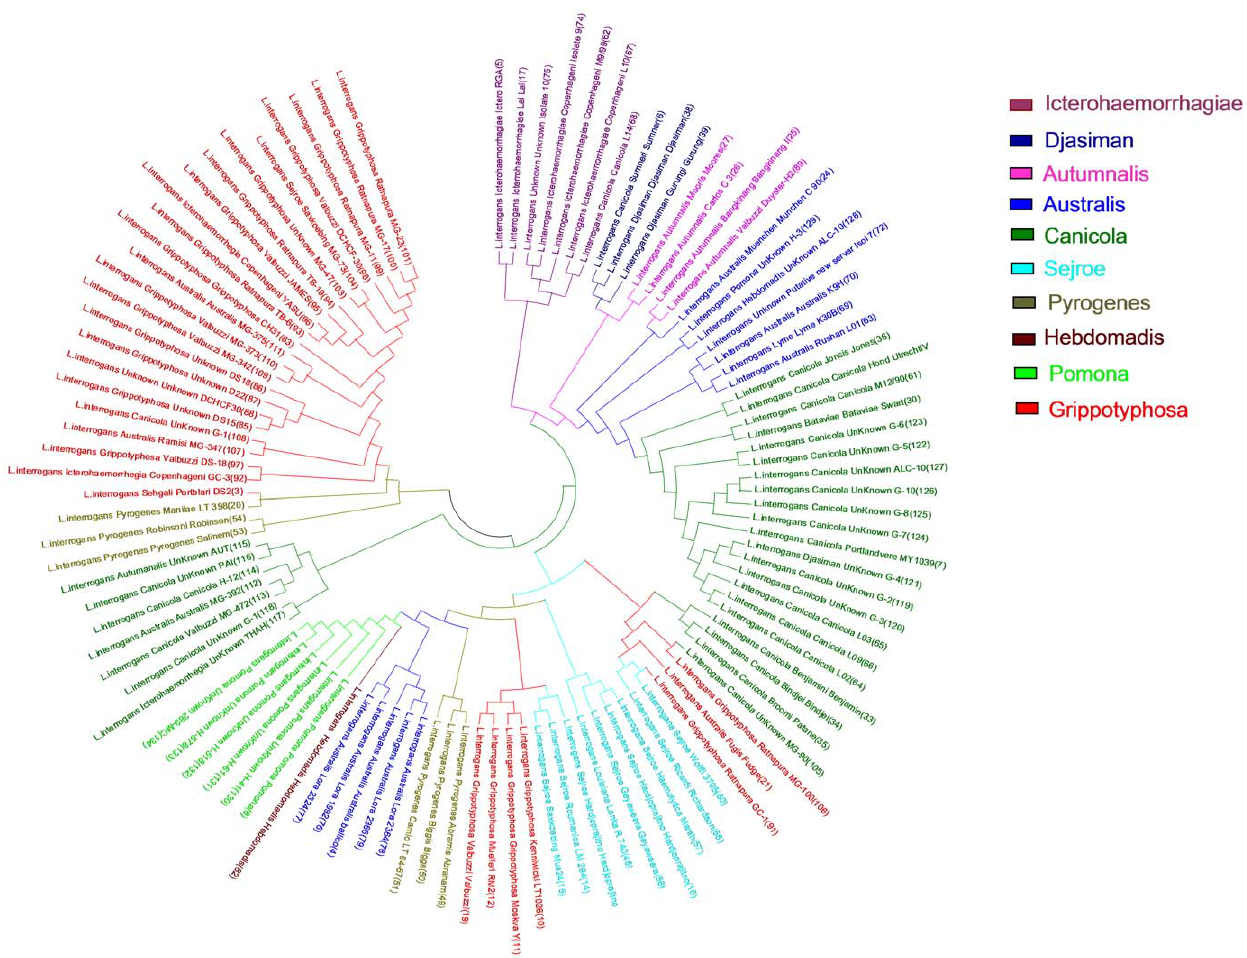
Figure 2. Genetic analysis of L.interrogans subsample based on MLVA analysis. Clusters corresponding to individual serogroups have been identified by different colors which have no correspondence with the color code of clusters shown in Figures 1 and 3. Please refer to supplementary information (Table S2) for details of the L. interrogans samples analyzed here. The phylogenetic tree was generated and visualized by using MEGA3.0 software.